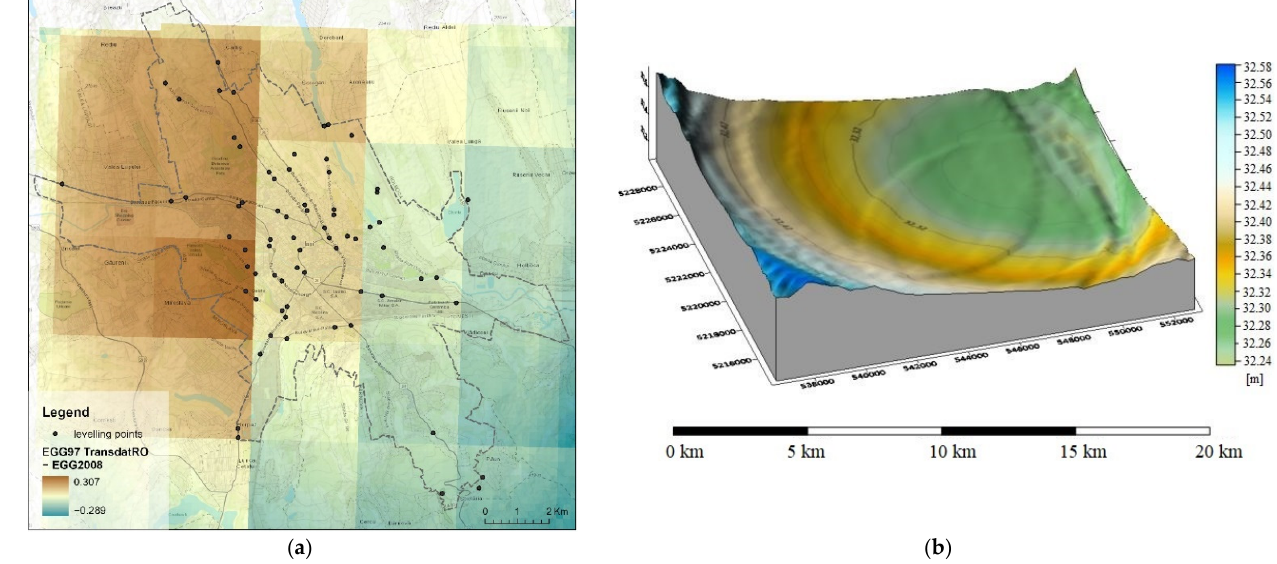
Figure 19. ( a ) The ellipsoidal height differences between the EGG97 TransDatRO and EGG2008 corrected grid; ( b ) 3D visualization of the correction surface of the EGG2008 grid for Iasi city (WGS84/UTM35N). Table 3. The residuals of 64 GCPs and 78 ChPs for two scenarios: uncorrected GNSS-RTK measure- ments and corrected GNSS-RTK measurements with the surface of the local